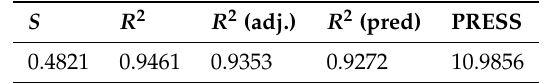
Table 8. Performance indicators of the Poisson regression model with dummy variables.